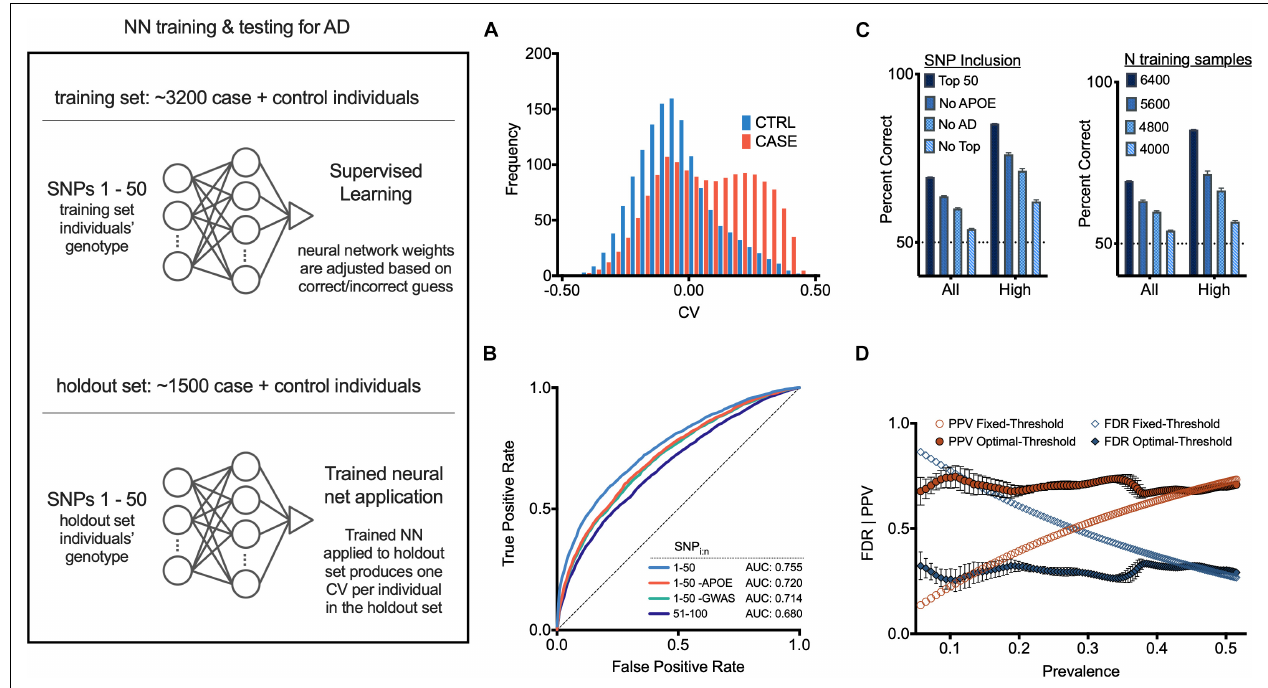
FIGURE 2 | Neural net prediction of case and control individuals. (Left) General neural net protocol and architecture; see text for details. (A) Histogram of neural net confidence value (CV) output for case (red) and control (blue) holdout set individuals. (B) Receiver operator characteristic (ROC) curves for indicated SNP sets as features. (C) (Left) Neural net accuracy for indicated populations using indicated SNP sets as features. “All CV” and “High abs(CV)” indicate inclusion of populations with 100% or top 30% abs(CV) values in accuracy calculations. Error bars, SEM. (Right) Neural net accuracy with indicated size training set; two samples (chromosomes) per individual. (D) False discovery rate (FDR) and positive predictive value (PPV) at each corresponding x -axis case prevalence, using a fixed CV threshold (set to 0) or optimal operating point classification threshold (see section “Materials and Methods”). Additional measures are in Supplementary Figures 9–11